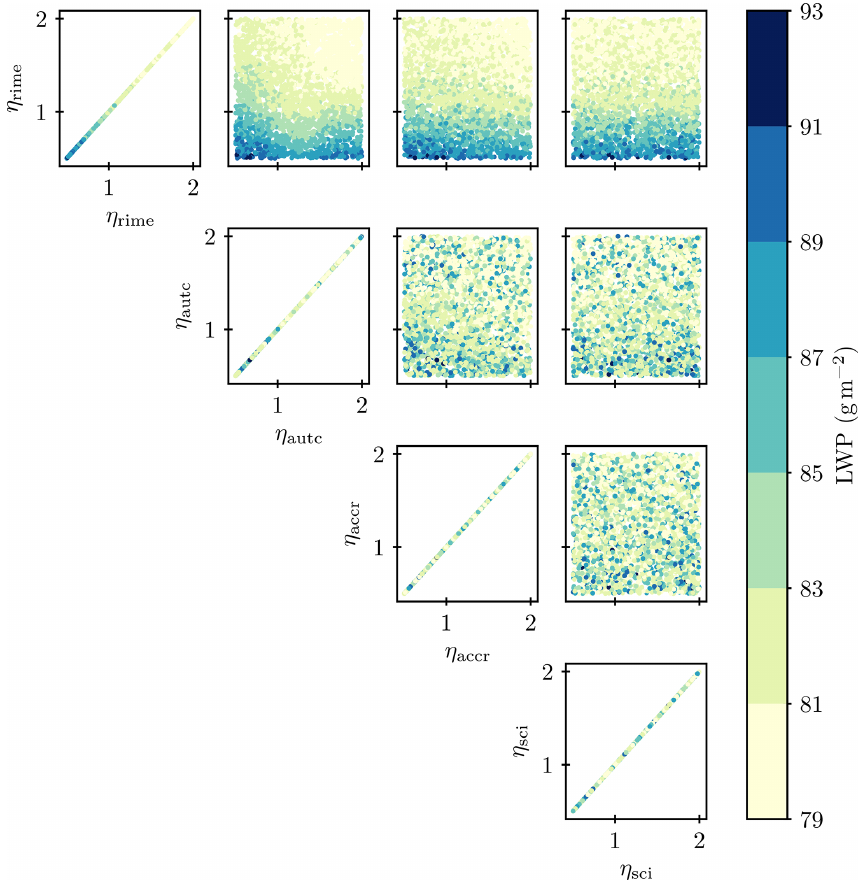
Figure 8. Same as Fig. 7 but for the global annual mean liquid water path. Results for additional variables are presented in Fig. B1 in Appendix